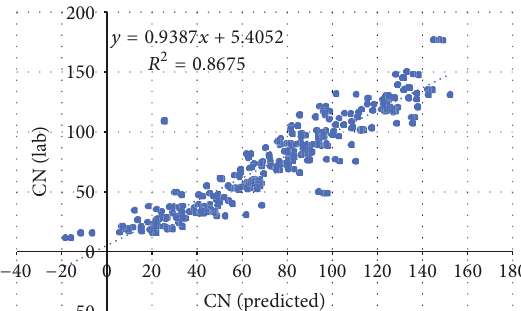
Figure 6: Linear regression relationship between laboratory refer- ence methods and NIRS-predicted values for C/N ( 𝑅 2 = 0.87 ) of winter and spring canola from 2011 on a dry weight